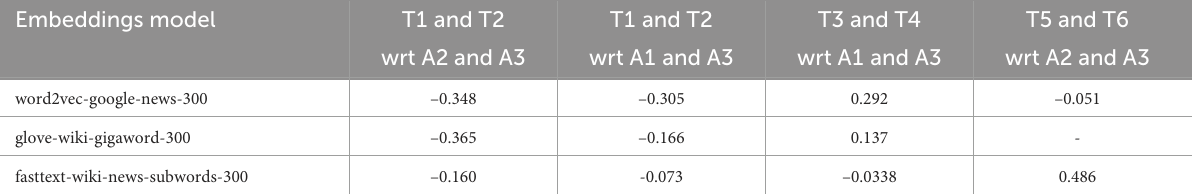
TABLE 4 F WEAT scores for embeddings with selected targets and attributes from Table 5. Embeddings model